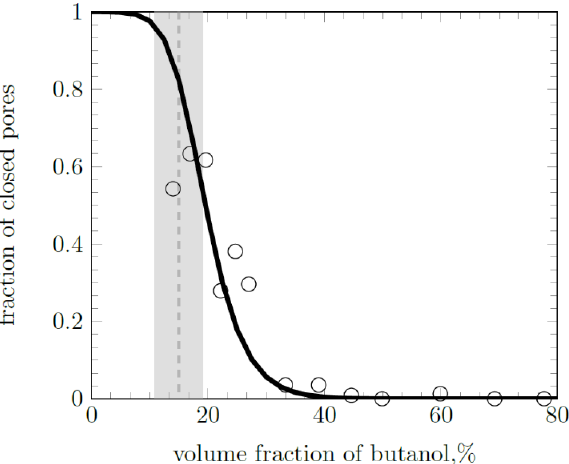
Figure 10. Fraction of closed pores depending on volume fraction of porogenic agent. The region of the percolation threshold is highlighted in gray.